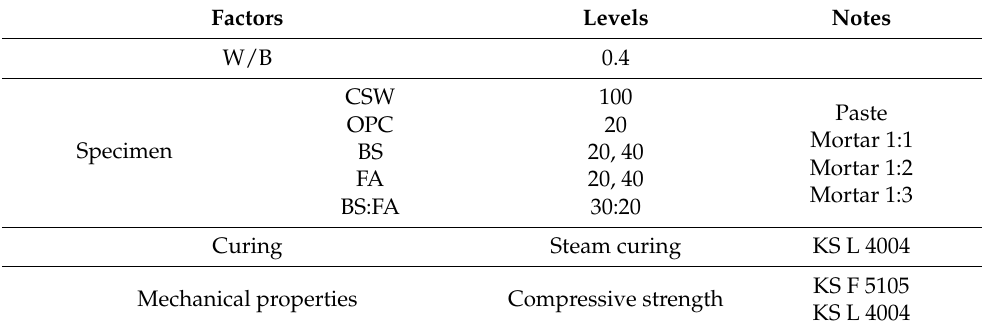
Figure 3. Concrete sludge waste (CSW) immediately after dehydration with moisture content of 40%. Table 3. Factors and levels.